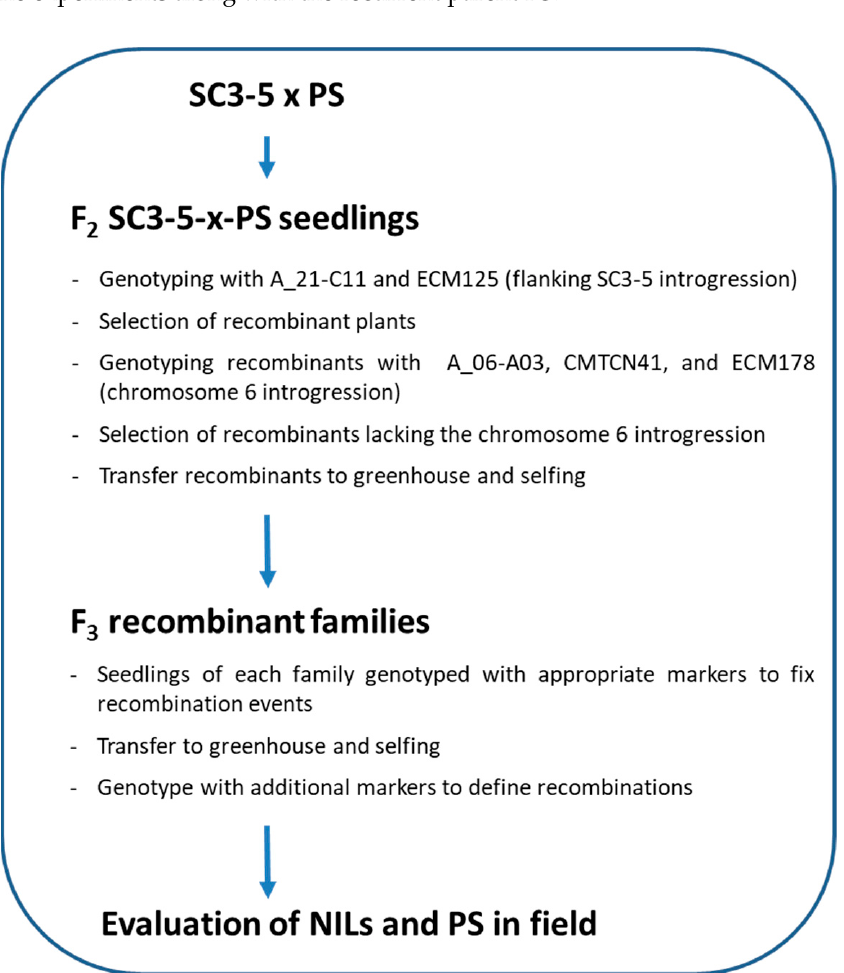
Figure 1. Mapping schedule used to obtain melon Near-Isogenic Lines (NILs) from SC3-5 and the parental PS.